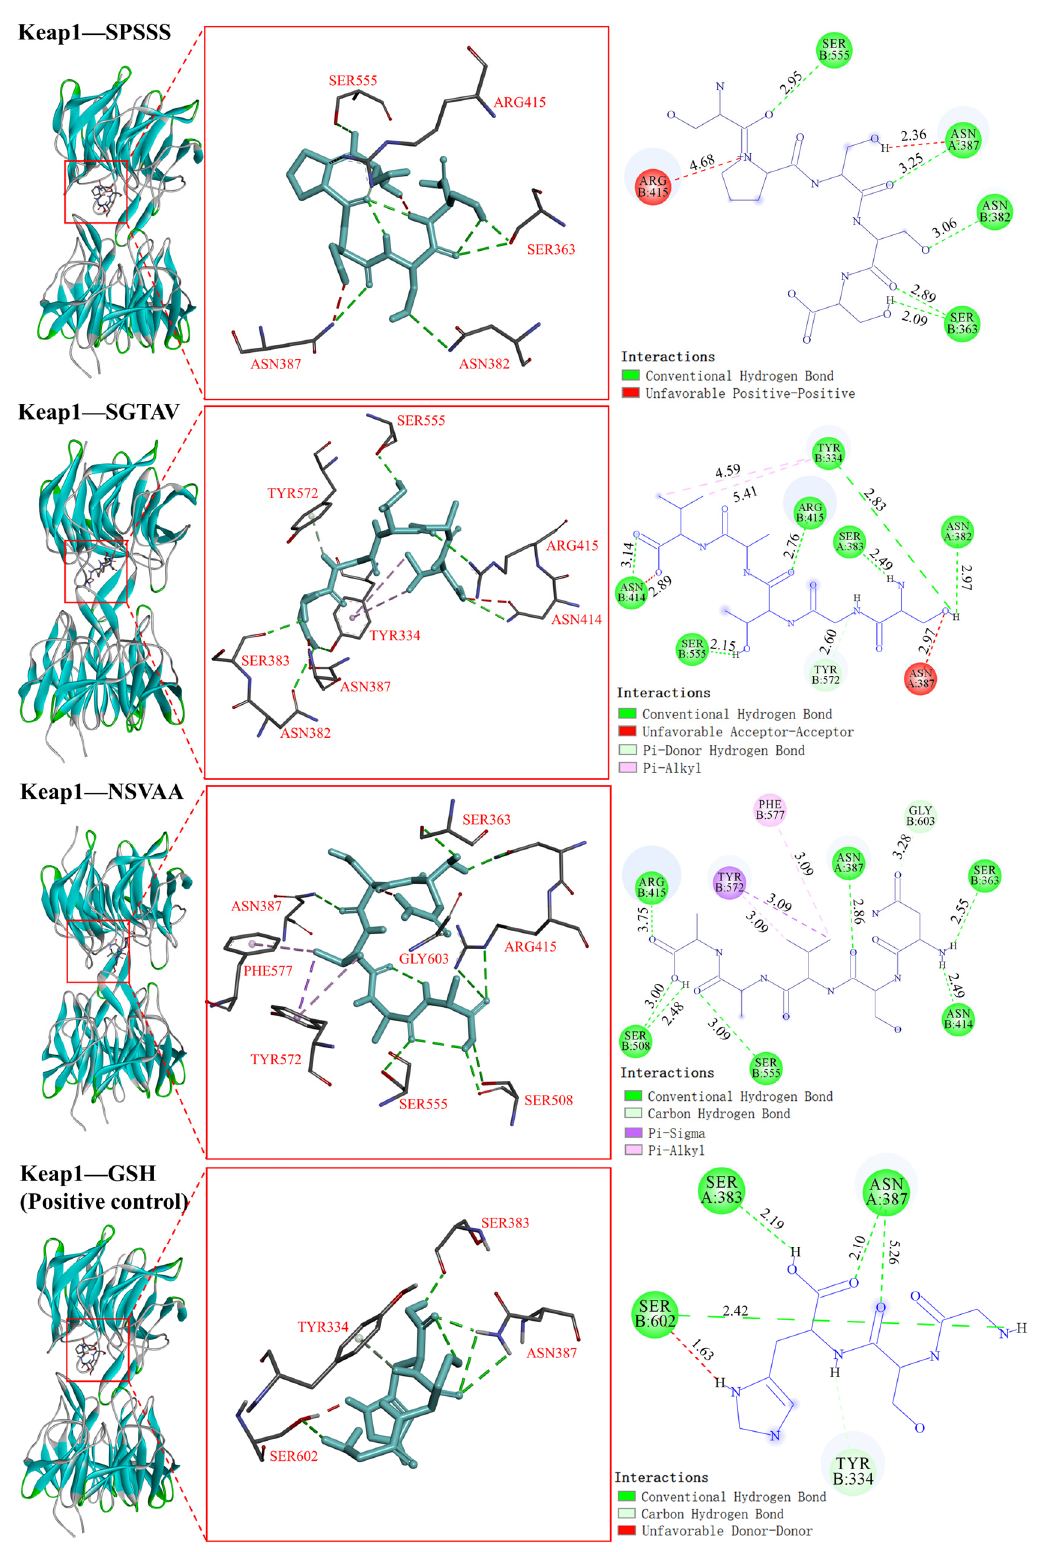
Figure 9. Visualization of molecular docking of antioxidant peptides SPSSS, SGTAV, and NSVAA and positive control (GSH) with Keap1.